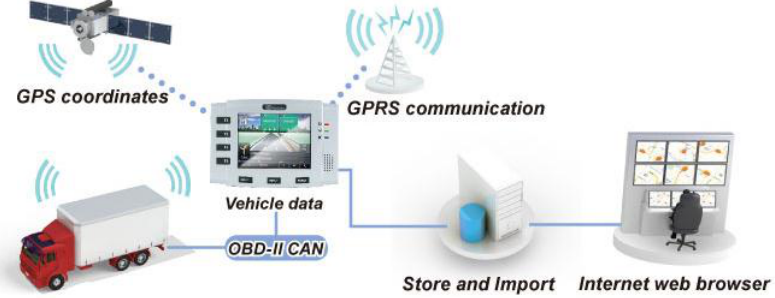
Figure 3. Truck management system architecture scheme [21]. GPS: global positioning systems; GPRS: general packet radio